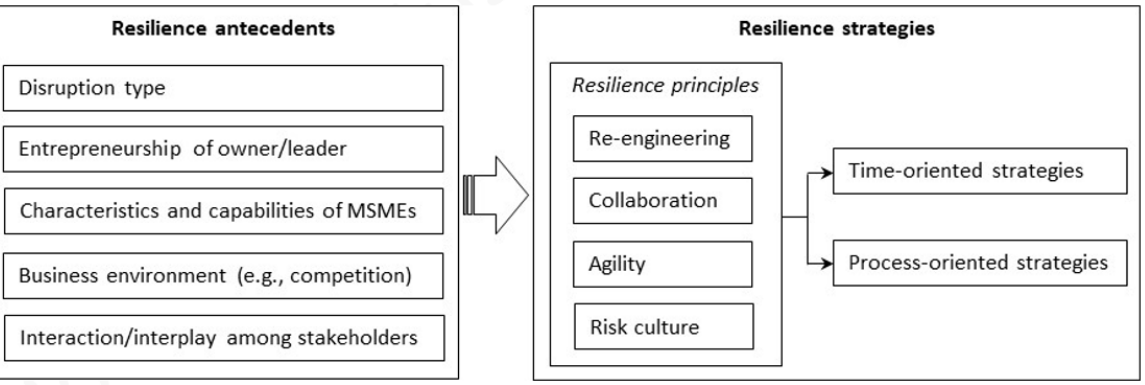
Figure 2. The framework of the resilience strategies modified from Kamalahmadi and Parast